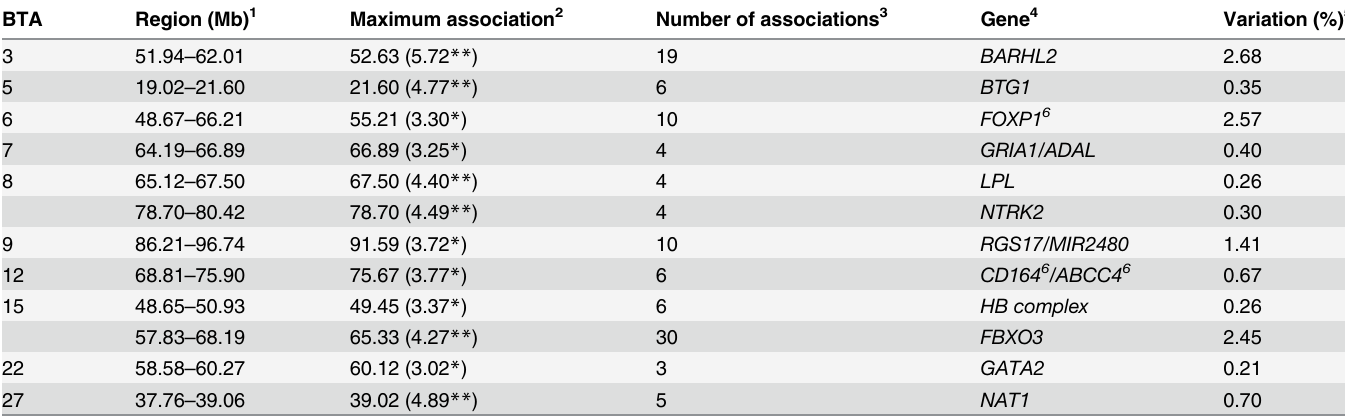
Table 1. Summary of most significant genomic regions associated with transformed mean FEC.